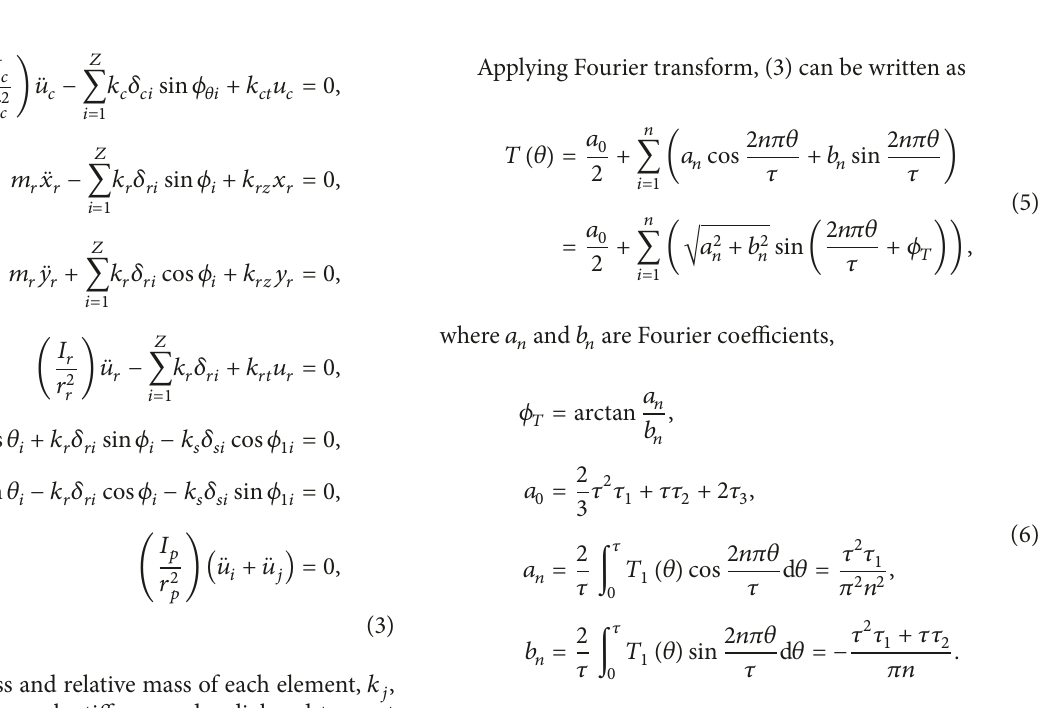
Figure 4: Output torque changes with rotational corner of